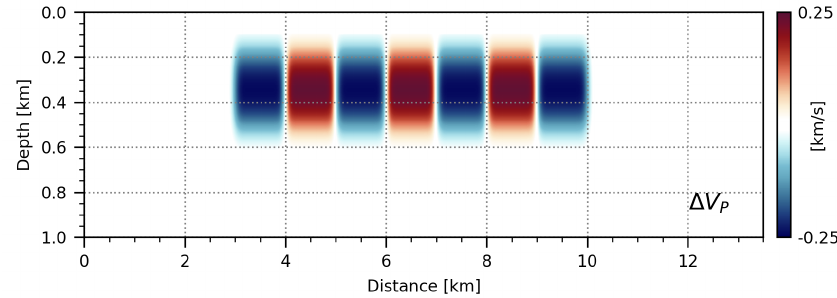
Figure 17. Target velocity perturbation ∆ V P .